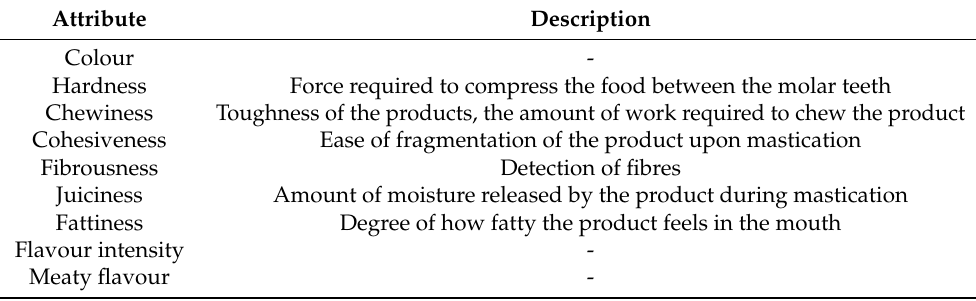
Table 1. Attributes used in the sensory test and their